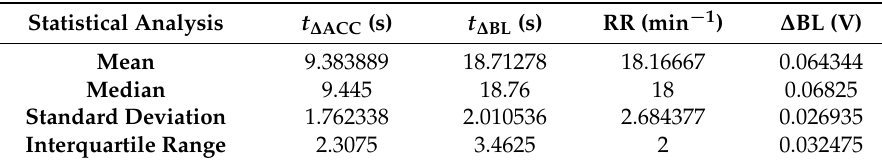
Table 7. Mean, Median, Standard Deviation, and Interquartile Range of Primary Parameters of Body Variation from Sitting to Standing.